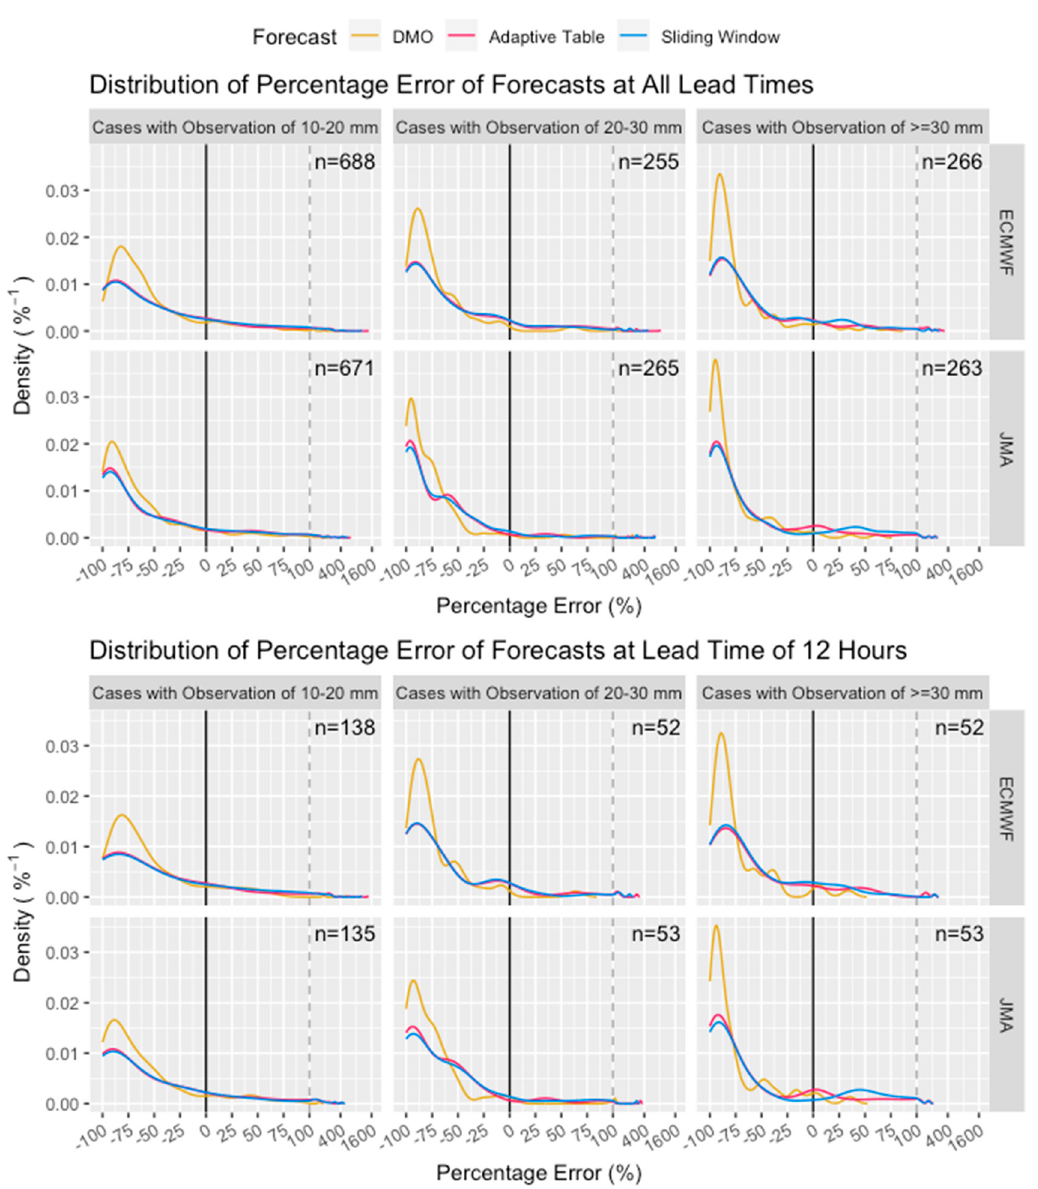
Figure 7. The density distribution of percentage errors of DMO and calibrated forecasts, by models and observation intensity categories, at ( the upper 6 panels ) all lead times, and ( the lower 6 panels ) specifically lead time of +12 h. The number n at the right-top corner of each panel denotes the number of cases, the difference of which across models is due to data availability. The scale of the horizontal axis is linear from − 100 to 100, and logarithmic onwards.